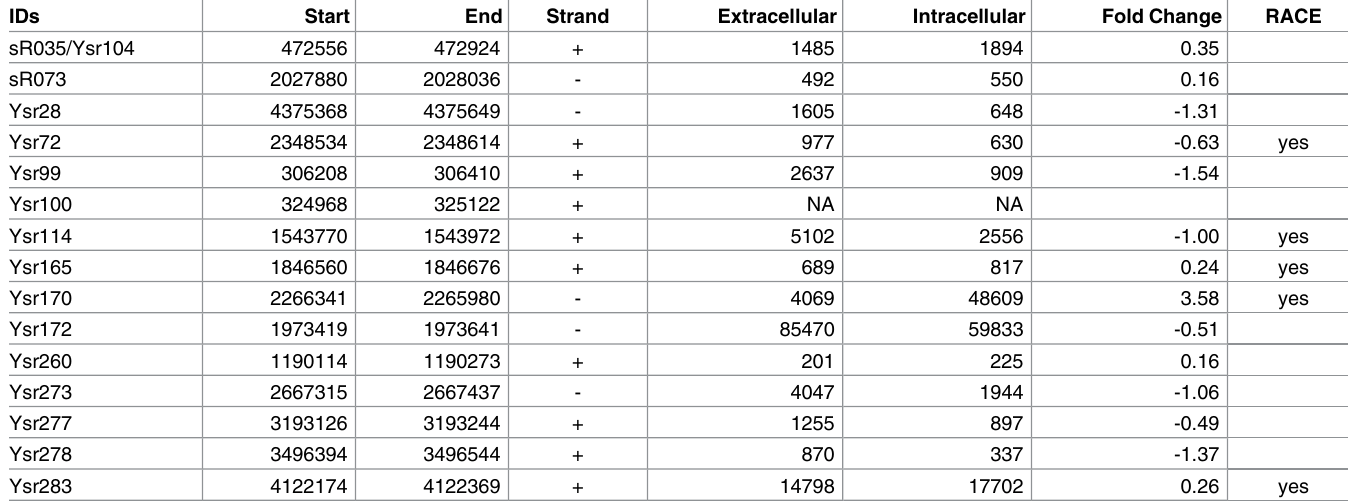
Table 2. List of validated sRNAsin this study.